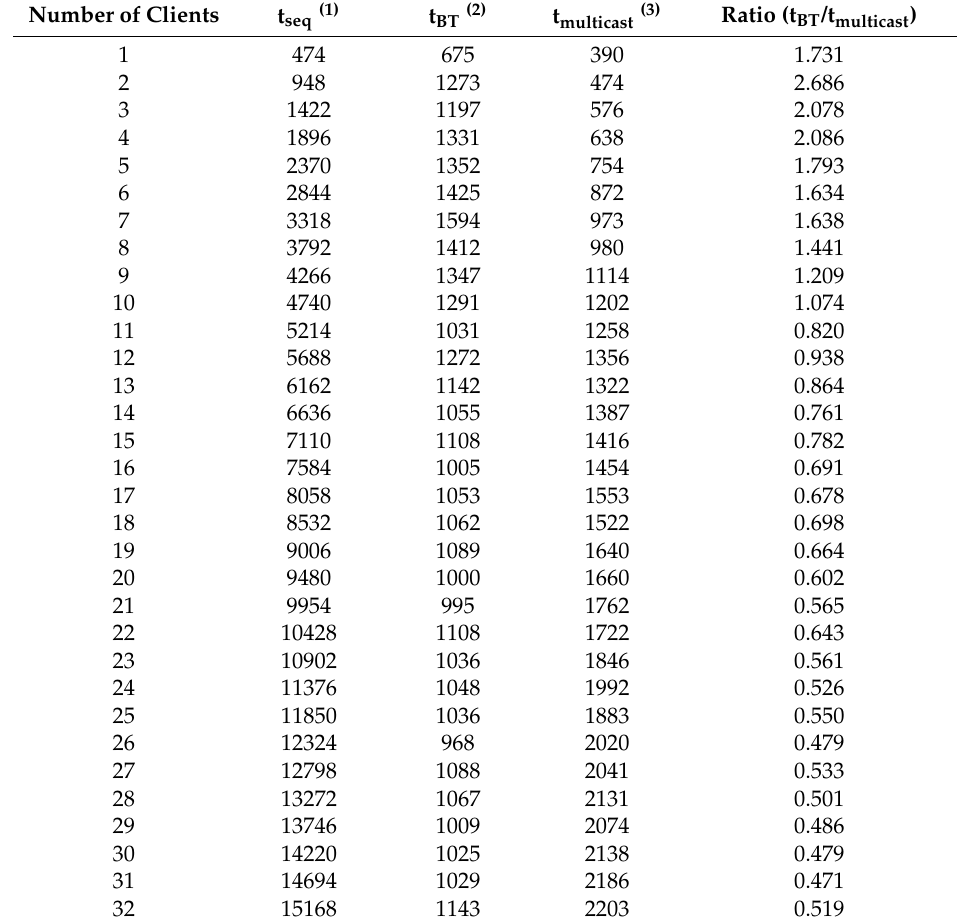
Table 2. Total time required to deploy a 50-GB Ubuntu Linux system and applications using the unicast, multicast, and BT solutions. GB: gigabyte.